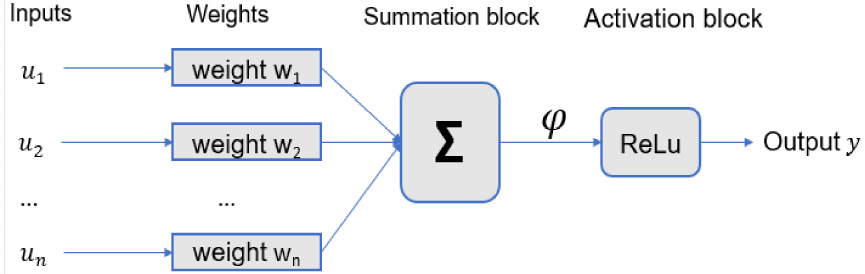
Figure 1. Scheme of the single neuron with n-inputs and ReLu activation